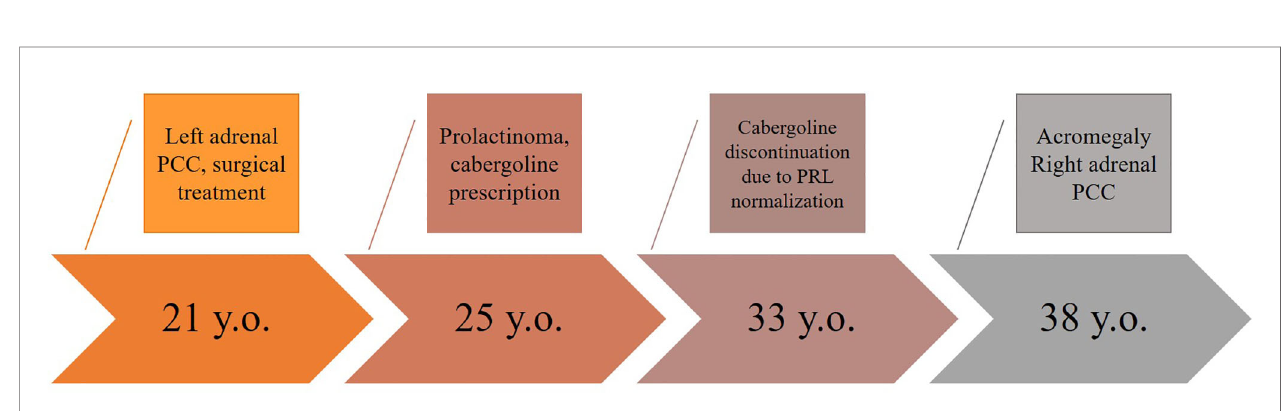
FIGURE 1 | Imaging results in our patient. CT of the abdomen: (A) arterial phase, axial projection, (B) arterial phase, sagittal projection. Three pheochromocytomas in the body and medial pedicle of the left adrenal gland (short arrows). Uniformly thickened lateral pedicle of the left adrenal gland (long arrow). The adrenal lesions were located close to each other, 21 × 22 × 23 mm, 24 × 14 × 19 mm and 24 × 22 × 24 mm. MRI of pituitary adenoma (long arrow) with cystic component (short arrow), subtotally replaces adenohypophysis: (C) T1 CE (contrast-enhanced) coronal projection, (D) T1 CE sagittal projection. The size of pituitary adenoma was 22 × 8 × 14.8 mm.